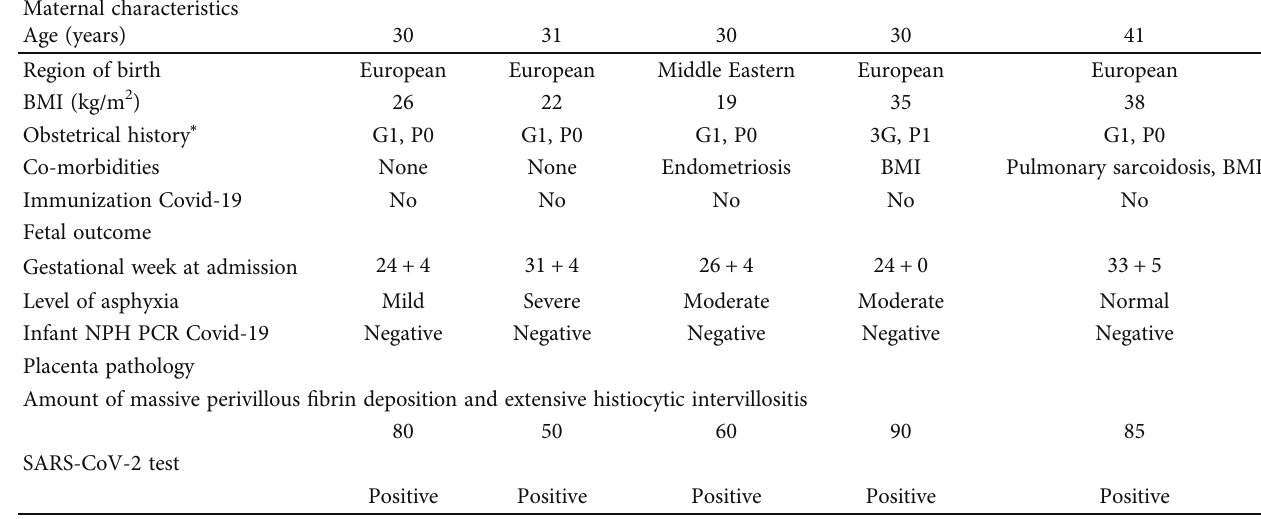
Table 1: Summary of all fi ve cases with maternal characteristics, fetal outcome, and placental pathology.